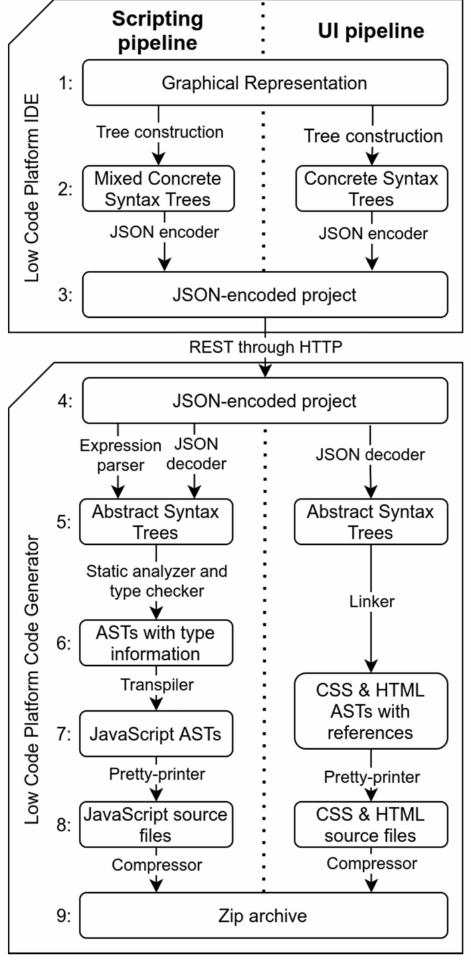
Figure 2. Pipeline detailing how the code is transformed from the visual representations into a fully fledged